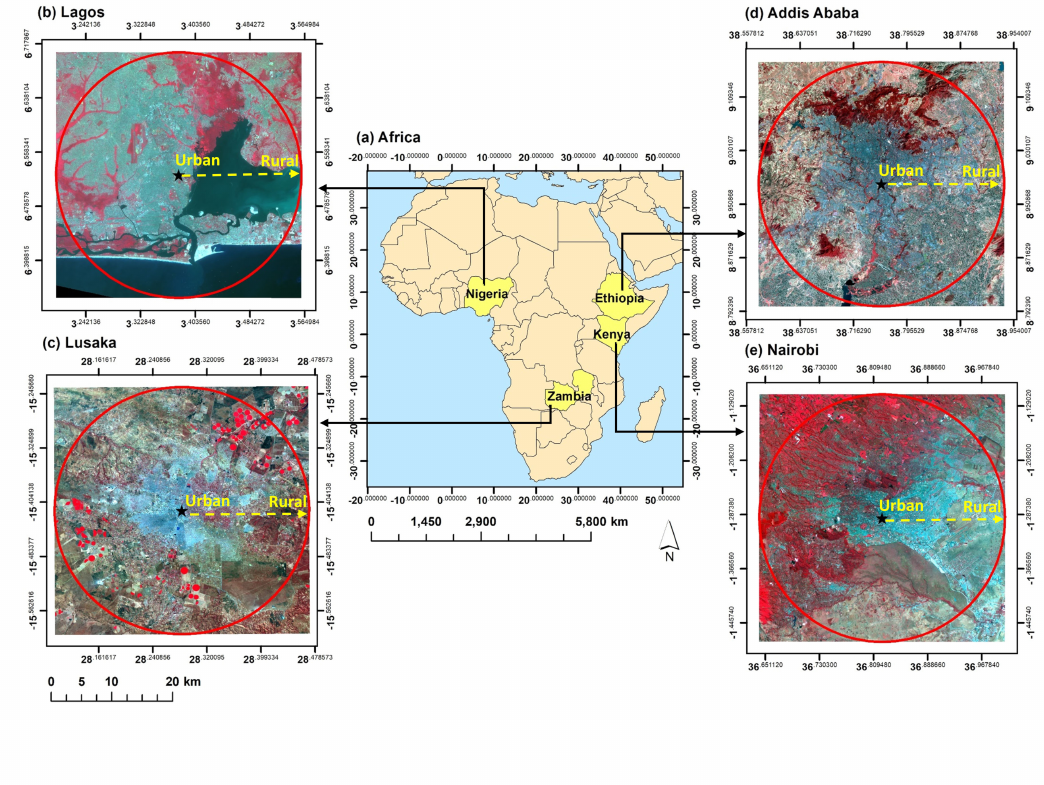
Figure 1. Location of study areas in Africa. Study areas are displayed using a false color composite of Landsat 8 images (band 5—red, band 4—green and band